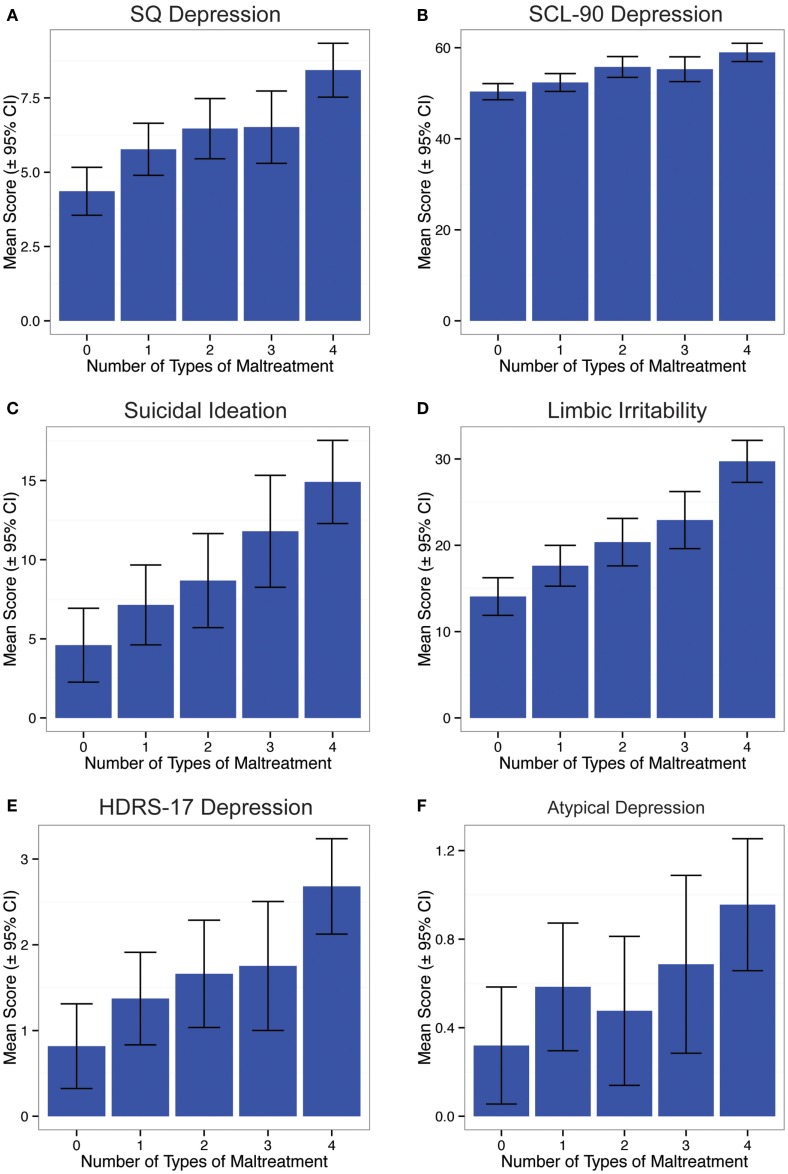
Relationship between number of different types of maltreatment experienced during childhood and (A) current rating of depression on Kellner’s Symptom Questionnaire, (B) current rating of depression on Symptom Checklist 90, (C) suicidal ideation on the Adult Suicidal Ideation Questionnaire, (D) limbic irritability of the Limbic System Checklist-33, (E) interviewer based depression ratings on Hamilton Depression Rating Scales, and (F) atypical depression rating on SIGH-SAD.